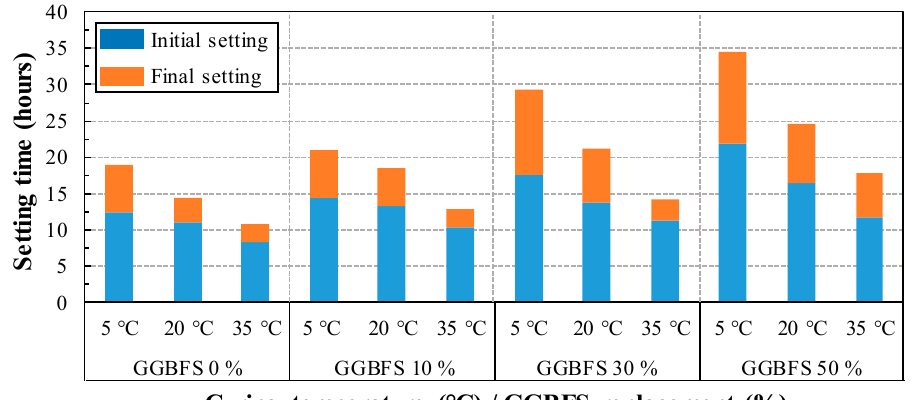
Figure 2. Setting time of mortar, according to curing temperature and replacement ratio of GGBFS.